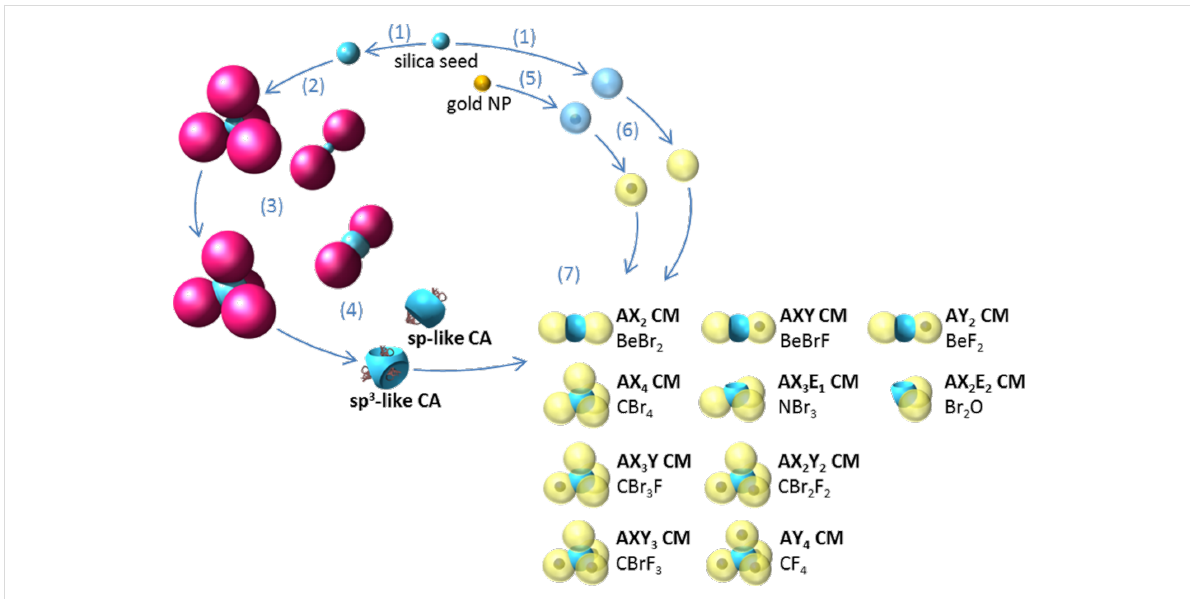
Figure 1: Synthesis of the CMs by covalent assembly of CAs: valence-endowed nanoparticles and nanospheres. (1) Growth of the silica seeds; (2) seeded-growth emulsion polymerization of styrene; (3) silica core regrowth; (4) dissolution of PS satellites for developing the dimples followed by the amination of the residual anchored PS chains at the bottom of the dimples; (5) growth of a silica shell around gold nanoparticles; (6) grafting of carboxylic acid groups at the silica surface of the nanospheres; (7) locking of carboxylated satellites within the aminated dimples through amide bond-